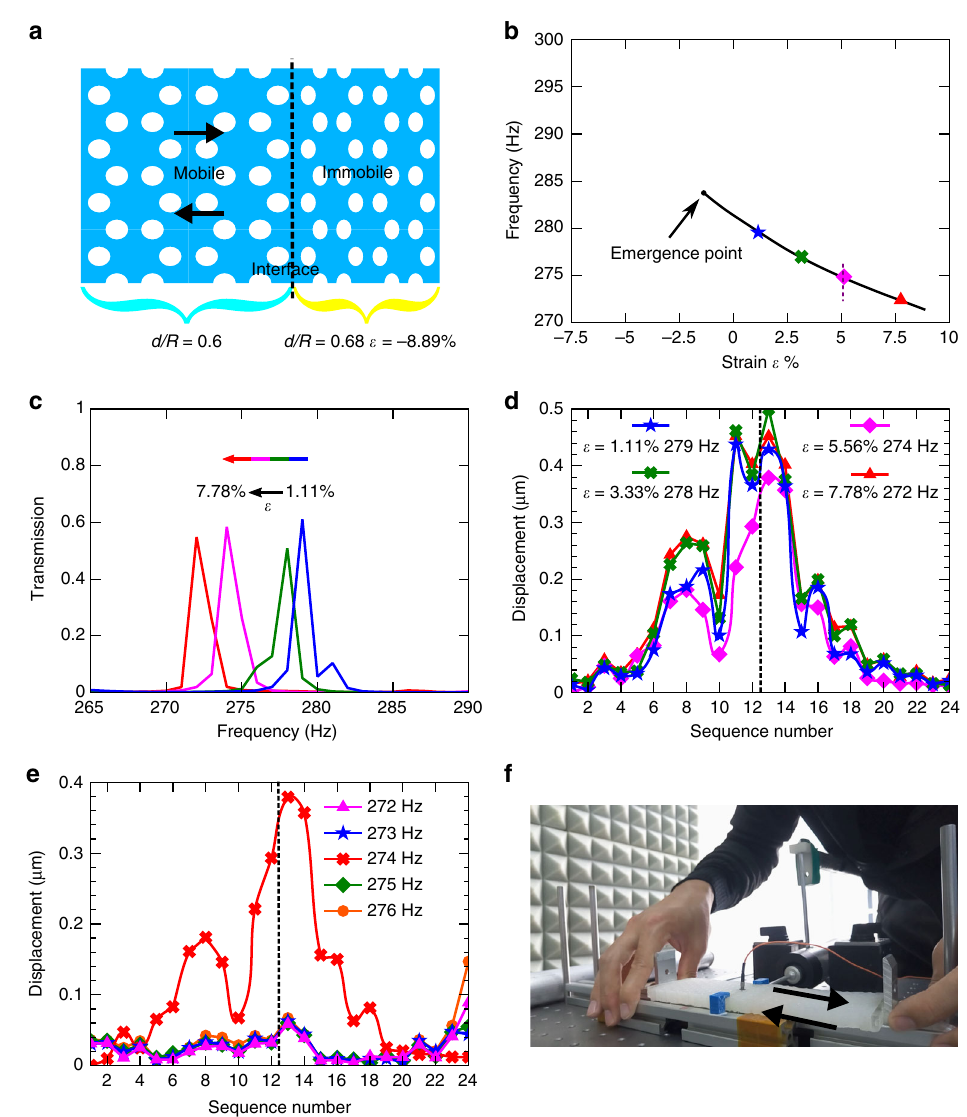
Fig. 5 Tunability of soft topological system. a The schematic of tunable topological system with two metamaterials, (0.6, ε 1 |0.68, − 8.89%), where strain ε 1 is variable in the range of − 5.56 ~ 8.89%. b The numerically simulated frequencies of topological interface state as a function of strain. The topological state emerges at a certain frequency and the frequency decreases as the strain increases. c The simulated transverse wave transmission peaks for four selected strains ε 1 = 1.11, 3.33, 5.56, and 7.78%, corresponding to the four colored symbols marked in b . d The experimentally measured vertical displacement fi eld distributions at four selected strains. The markers and colors have their correspondences in b . e The experimentally measured displacement fi eld distributions at fi ve selected frequencies at strain of 5.56% along the purple dashed line in b , 272, 273, 274, 275, and 276 Hz. f A snapshot of experimental demonstration of dynamical manipulation of topological interface state. The black dashed lines in a , d , and e indicate the position of interface between two a variable in the range of − 5.56 ~ 8.89%. According to the topological phase diagram (Fig. 2b), the metamaterial (0.68, − 8.89%) at right side has a relatively large bandgap in the fre- quency range of 263 ~ 298 Hz. While the metamaterial (0.6, ε 1 ) at left side has a common gap with that at right side when ε 1 changes in the range of − 1.11 ~ 8.89%. Figure 5b presents the numerically calculated topological interface states only emerged within the solid line in the frequency range of 271 ~ 285 Hz when strain ε 1 changes in the range of − 1.11 ~ 8.89%. We selectively choose four topological interface states in the solid line (Fig. 5b)